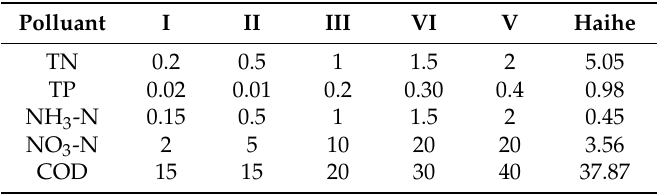
Table 2. Mean concentration and Guidelines (GB3838-2002) of nutrients compounds in surface water (mg/L).